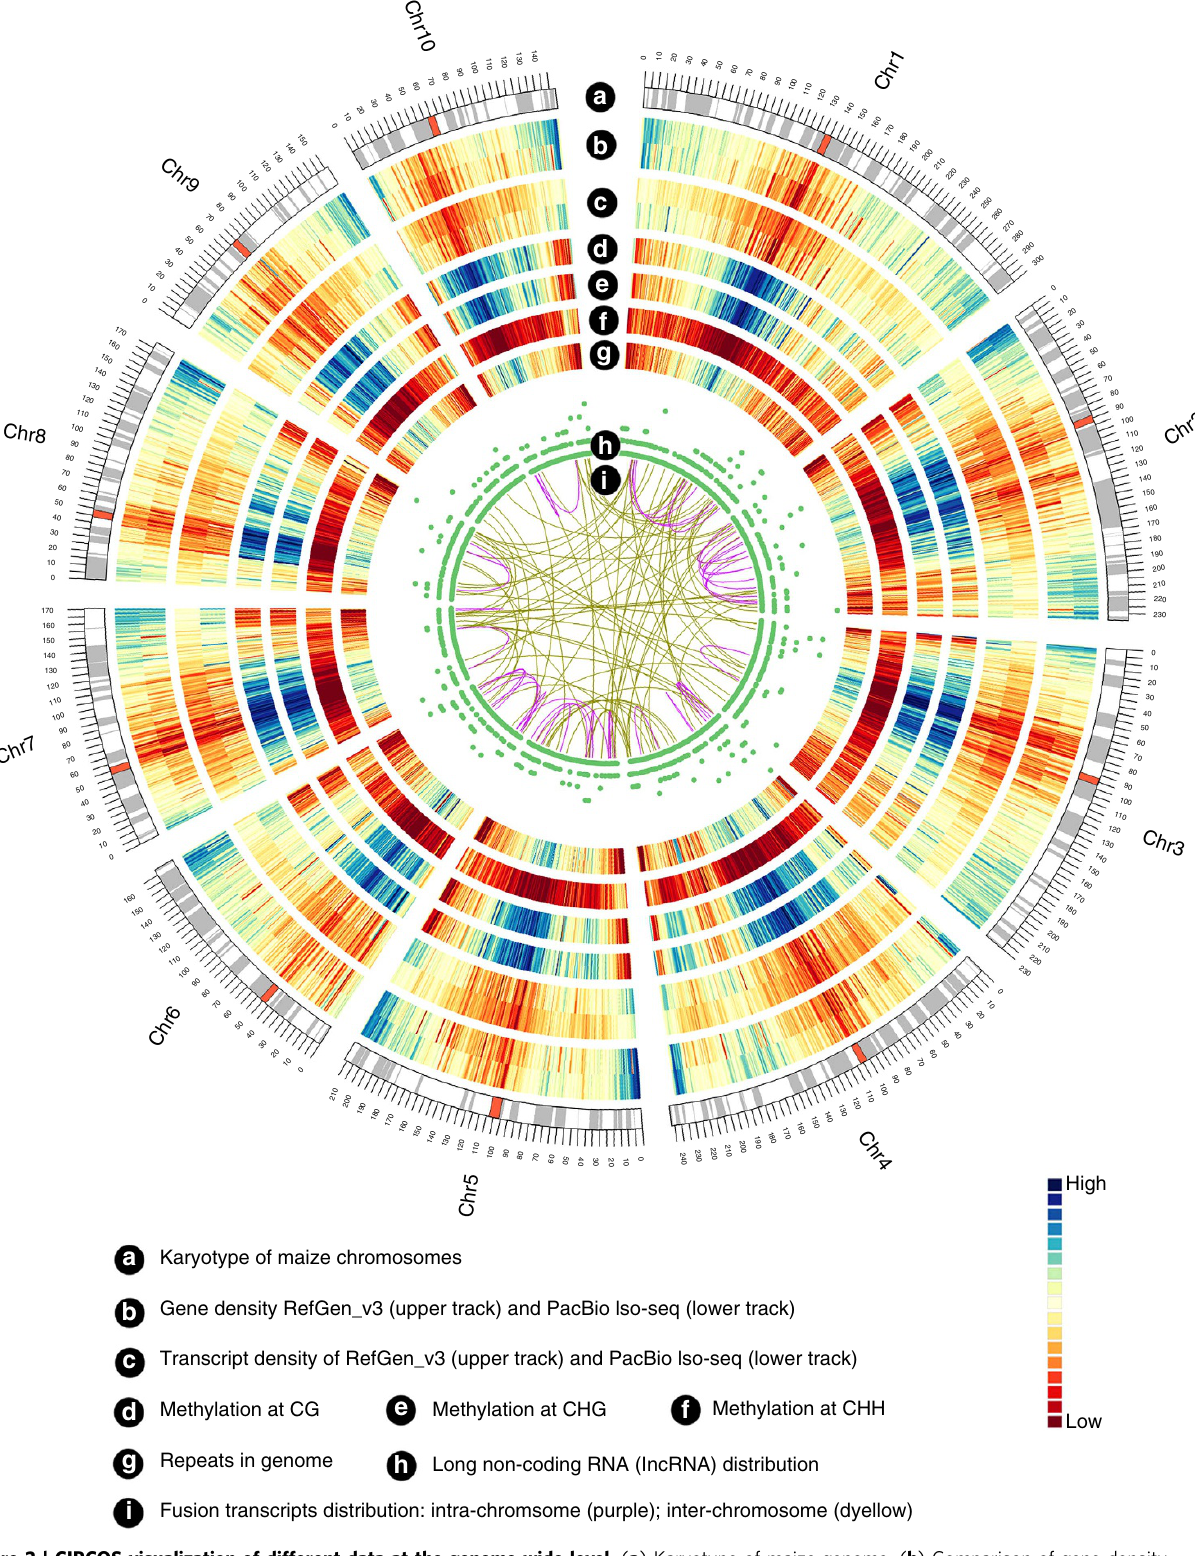
Figure 2 | CIRCOS visualization of different data at the genome-wide level. ( a ) Karyotype of maize genome. ( b ) Comparison of gene density between genes covered by RefGen_v3 and the PacBio data set. Gene density was calculated in a 1-Mb sliding window at 20kb intervals. ( c ) Comparison of isoform density between RefGen_v3 and PacBio sequences; isoforms density was calculated in a 1-Mb sliding window at 20kb intervals. ( d ) CG methylation level. ( e ) CHG methylation level. ( f ) CHH methylation level. Each methylation in 1Mb bins on each chromosome. ( g ) Repeat density in genome. ( h ) lncRNA density, in 1Mb bins on each chromosome. ( i ) Linkage of fusion transcripts: purple, intra-chromosomal; dark yellow,